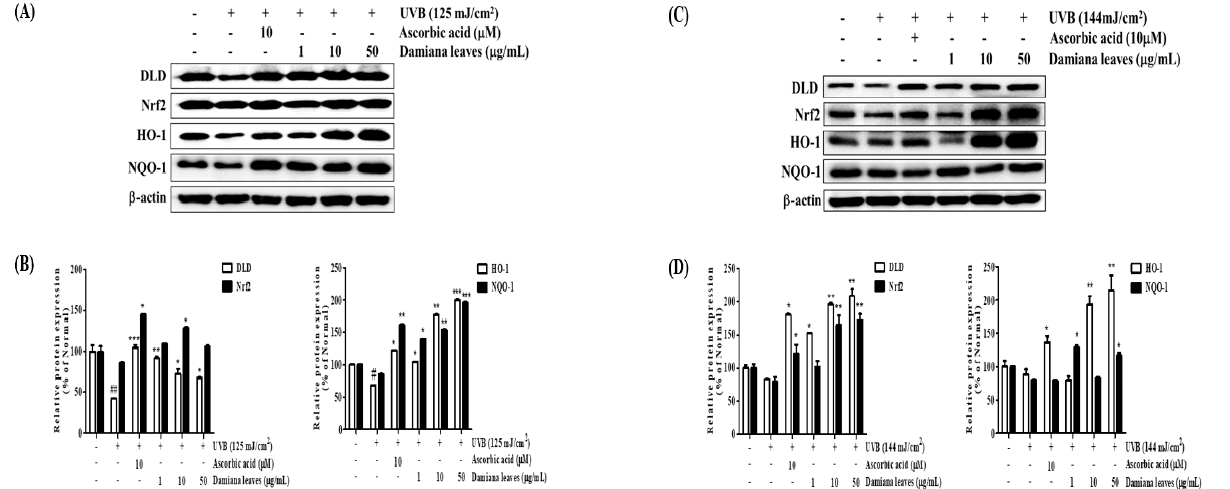
Figure 11. Effect of Damiana leaves extract on protein expression Nrf2, DLD, HO-1, and NQO-1 signaling pathway on UVB-irradiated HaCaT ( A , B ) and HDF ( C , D ) cells. Data are presented as the mean ± SD. # and * indicate significant differences from the non-irradiated control and UVB-treated groups, respectively. # and ## p < 0.05 and 0.01 vs. the non-treated group. *, ** and *** p < 0.05, 0.01, and 0.001 vs. the UVB-treated control, respectively.